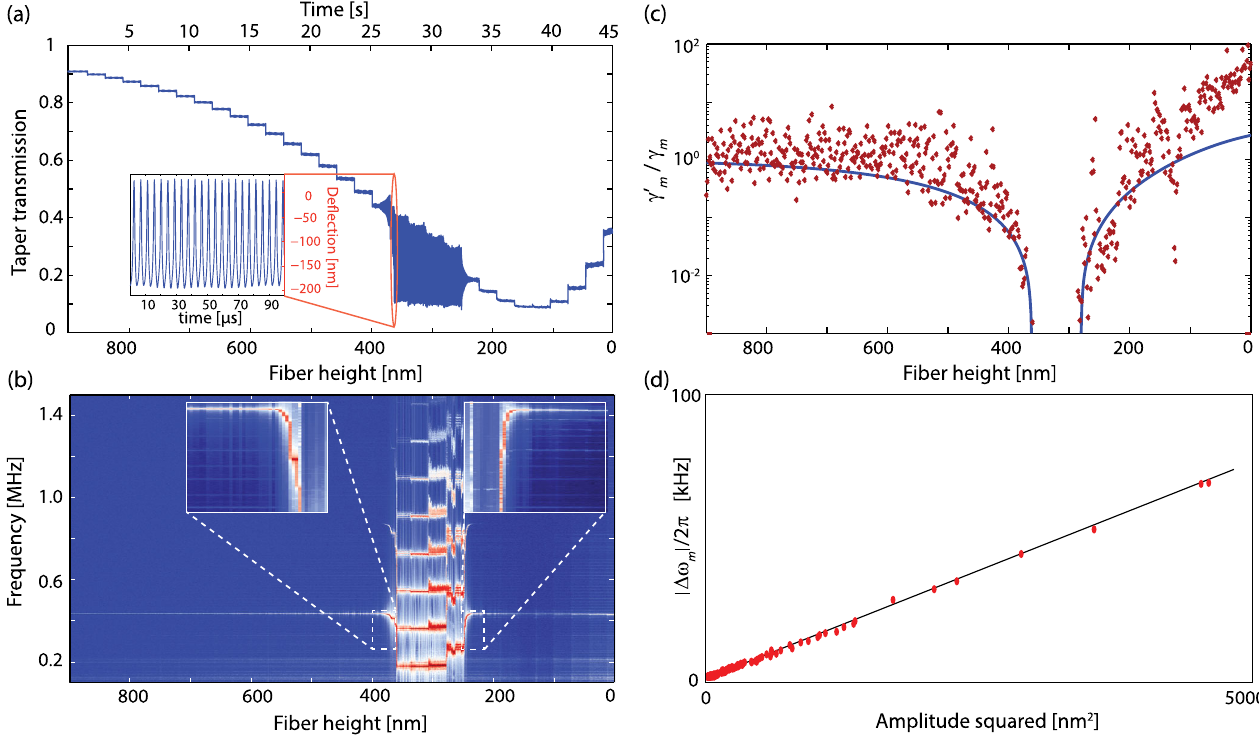
FIG. 5. Nanobeam self-oscillations. (a) Time-resolved T ð h ð t ÞÞ of a phase-matched fiber taper nanobeam ( L × w × d ¼ 80 × 0 . 50 × 0 . 25 μ m 3 ) system as h is reduced in discrete steps (visible as sharp steps in T ). Inset: Large-amplitude oscillation of the nanobeam position. (b) Spectrograph showing the power spectral density of the data in (a). (c) Predicted renormalized mechanical dissipation rate compared with measured values. (d) Scatter plot of shift in nanobeam resonance frequency versus oscillation amplitude squared for data in the inset regions from (b) at the onset of self-oscillation. The solid line is a linear guide to the